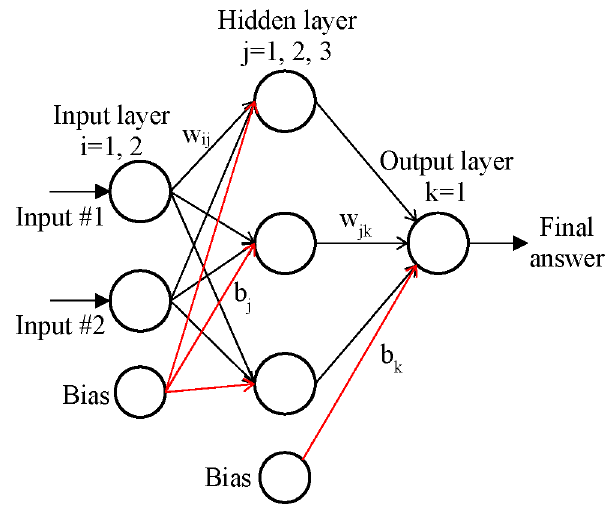
Figure 1. Schematic view of an ANN model with one hidden layer.